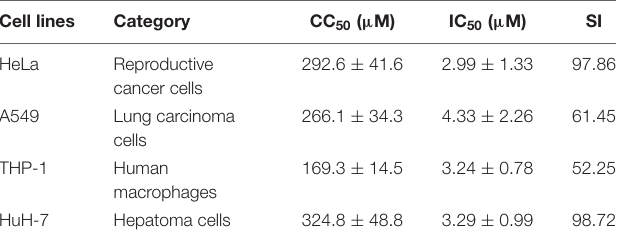
TABLE 3 | Cytotoxicity in vitro and selective index values of tolcapone against all tested cells a